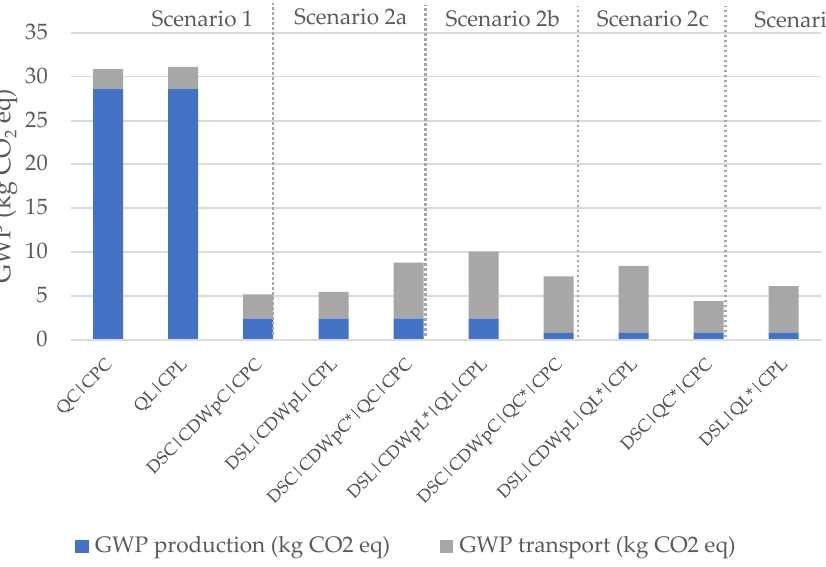
Figure 4. GWP for production and transport of 1 tonne of aggregates.